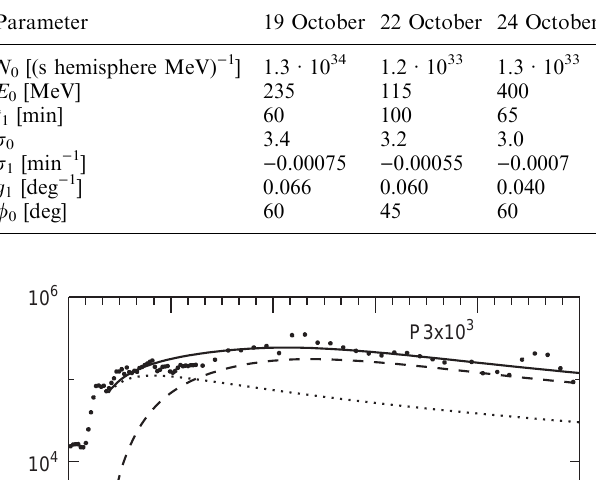
Table 2. Delayed injection parameters of the October 1989 SEP events Parameter